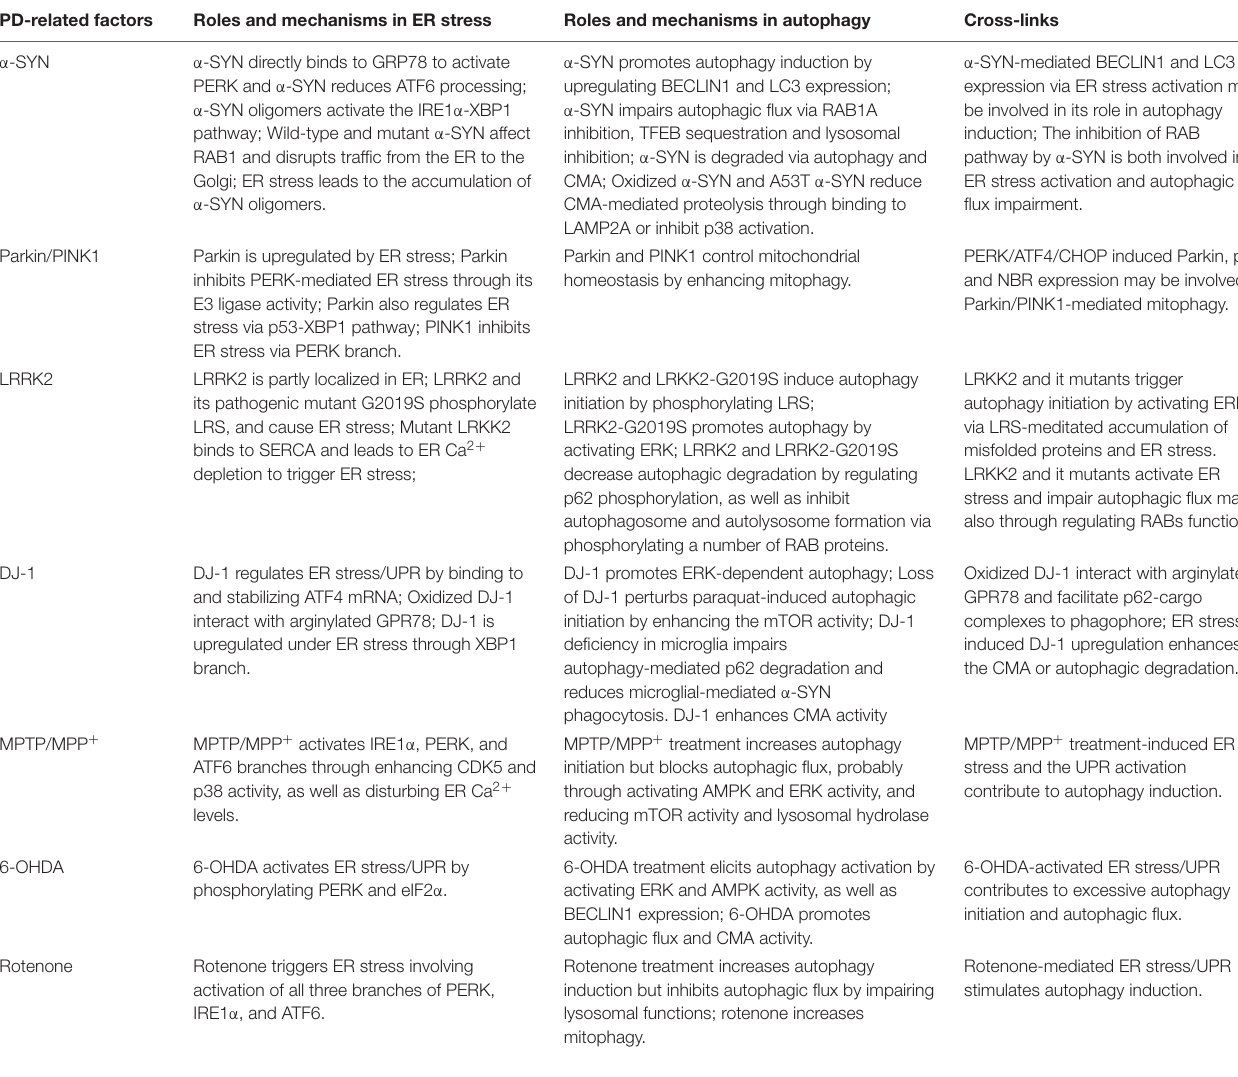
TABLE 1 | The roles and mechanisms of PD-related factors in ER stress, autophagy and their